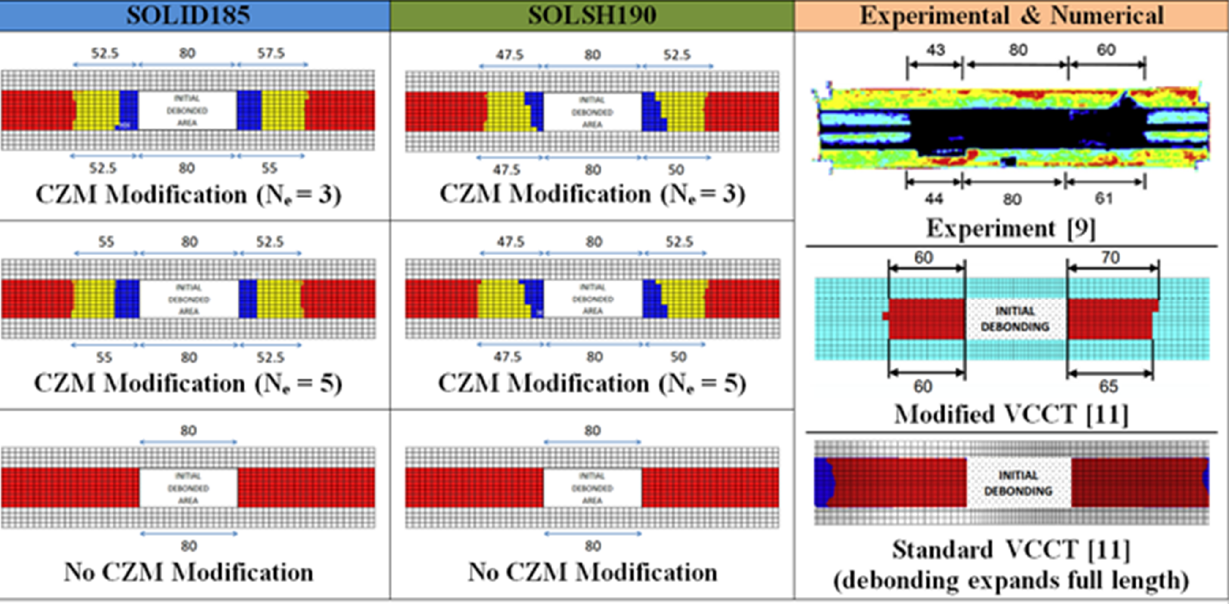
Figure 6. Comparison of FE results (5 mm element length) regarding the final debonding length with experimental and numerical ones from the literature.